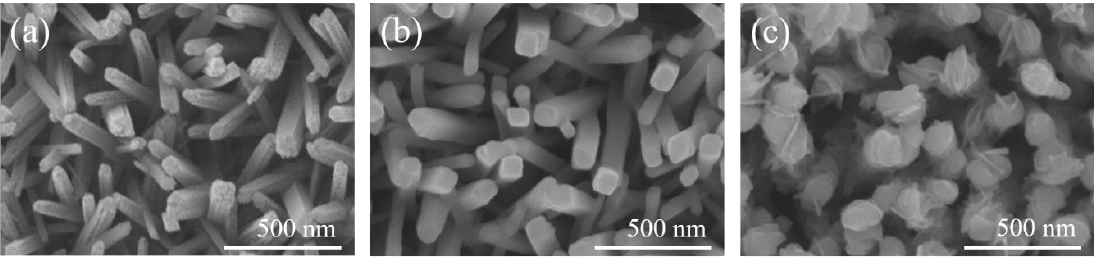
Figure 1. Scanning electron microscope (SEM) images: ( a ) TiO 2 rods. ( b ) TiO 2 /s – Bi 2 O 3 rods, ( c ) TiO 2 /a – Bi 2 O 3 rods.